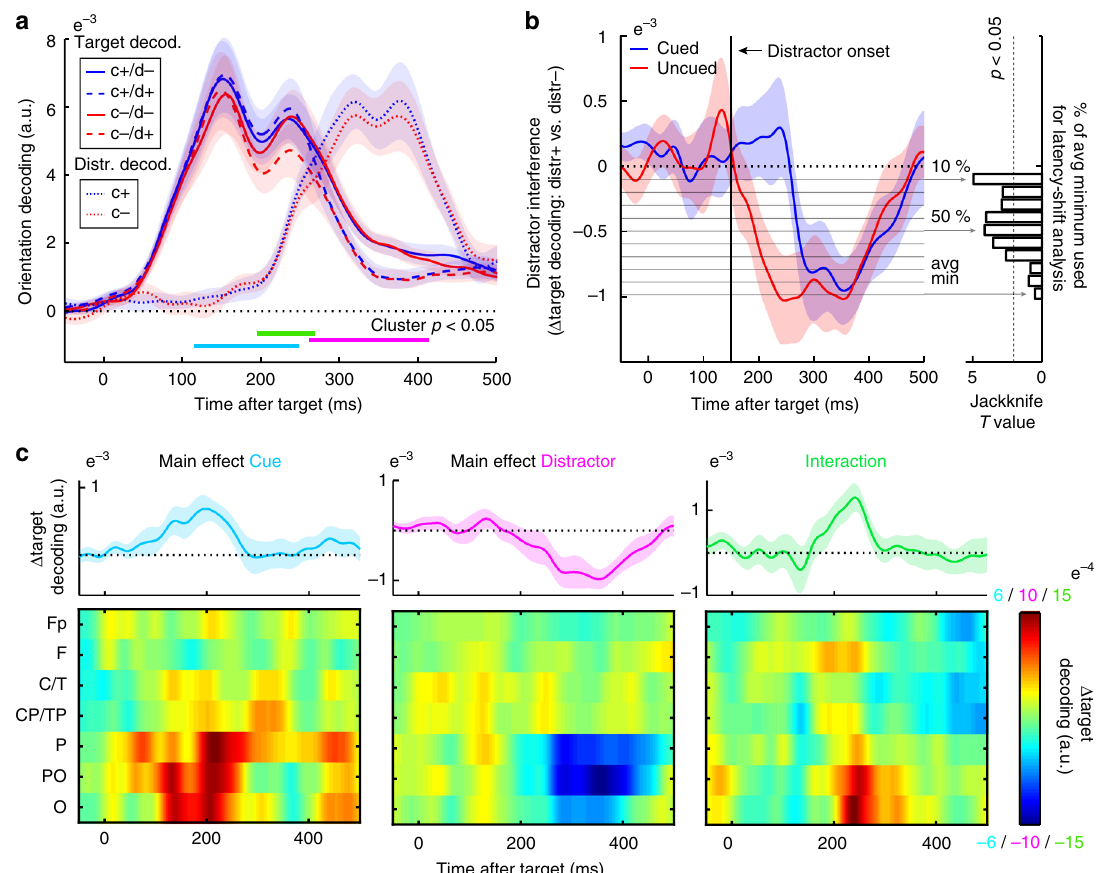
Fig. 4 Anticipation increases target identity information and delays distractor interference in early visual EEG responses. a Time courses of target and distractor orientation decoding (summary statistic) as a function of cue presence (blue for cued, 'c + '; red for uncued, 'c − ') and distractor presence (solid for distractor-absent, 'd − '; dashed for distractor-present, 'd + '). Horizontal lines mark where the clusters of the contrasts that survived cluster-based permutation statistics were observed in the non-permutated data for the main effects of cue presence (light blue), distractor presence (pink), as well as their interaction (green). All clusters involve target decoding; no signi fi cant cueing effect cluster was observed for distractor decoding. b Time courses of the distractor interference effect on target decoding. Distractor interference is quanti fi ed as the difference in target decoding for distractor-present vs. absent trials. Right panel shows Jackknife T values for latency differences between cued and uncued trials at thresholds ranging from 10 to 100% of the maximal interference effect. Maximal interference was calculated as the lowest value in the average of the cued and the uncued trials (denoted 'avg min'). c Main and interaction effects as a function of time and electrode row. The interaction is expressed as the difference between cue-present vs. absent trials in distractor-present vs. absent trials. Upper plots show decoding based on the same channels as in a (see Fig. 2a). Shadings represent ± 1 s.e.m. calculated across participants ( n =